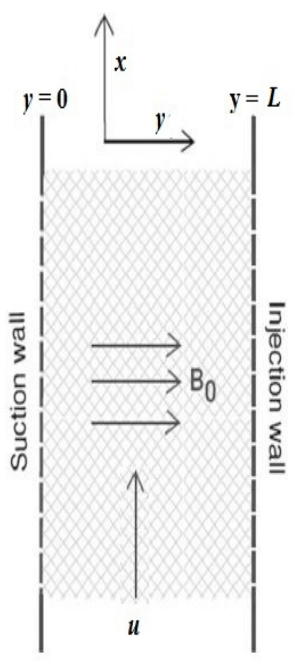
Figure 1. Construction of the